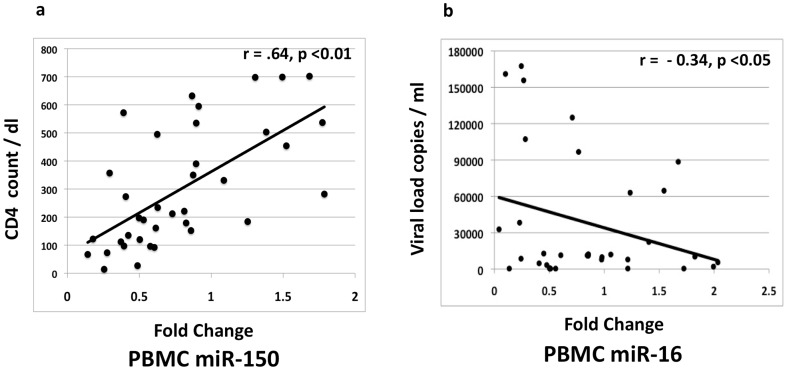
Correlation of miRNA levels with CD4 counts and viral load.The correlations are shown for (a) miR-150 in PBMCs with absolute CD4+ T-cell counts and (b) miR-146b-5p in PBMCs with HIV viral loads. A positive significant correlation was noted between miR-150 and CD4 cell count (r = 0.64; p<0.01) and an inverse correlation between miR-146b-5p and HIV viral loads (r = −0.34; p<0.05).